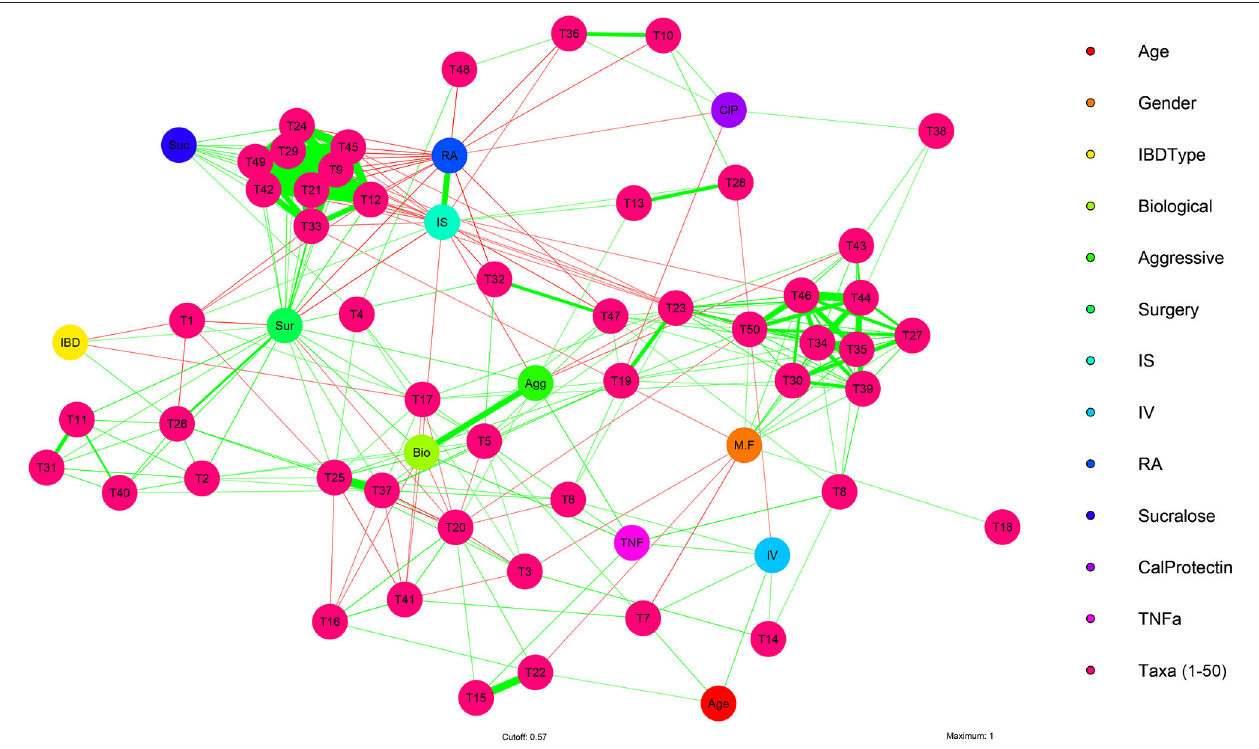
FIGURE 4 | Multivariate analysis of IBD clinical, experimental, and microbiome features. Visualization of multiple significant associations present in clinical and experimental features of IBD subjects with fecal microbiome bacteria (species) using a multivariate network analysis in IBD subjects ( n = 41). Positive correlations (green arrows), negative correlations (red arrows), strong (thick edges) and weak (thin edges, less saturated) correlations between IBD subject clinical and experimental features, plus bacterial species are shown. Correlation arrows displayed are significant ( P < 0.05) and have R values > 0.30. Reference Supplementary Tables 3, 4 for and statistical data and graphical